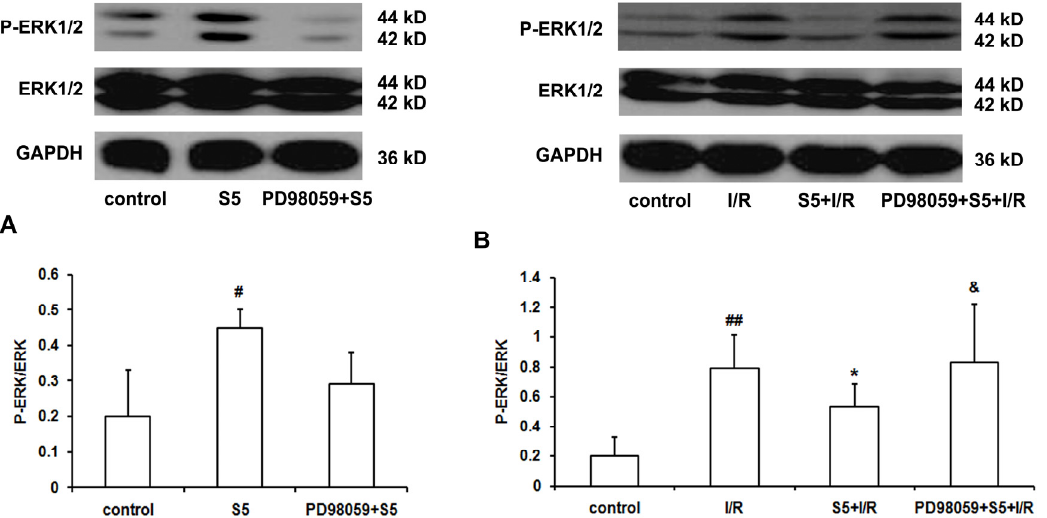
Figure 2. Phosphorylated ERK1/2 protein expressions of myocardium in vitro . SO phosphorylation of ERK1/2 protein in rat myocardium ( A ); SO the excessively-induced myocardial phosphorylation of ERK1/2 protein induced by ischemia/reperfusion. Pretreatment with PD98059 successfully abolished the above inhibitory effect ( B ). # p < 0.05; ## p < 0.01 versus control; * p < 0.05 versus I/R; & p < 0.05 versus S5 + I/R.